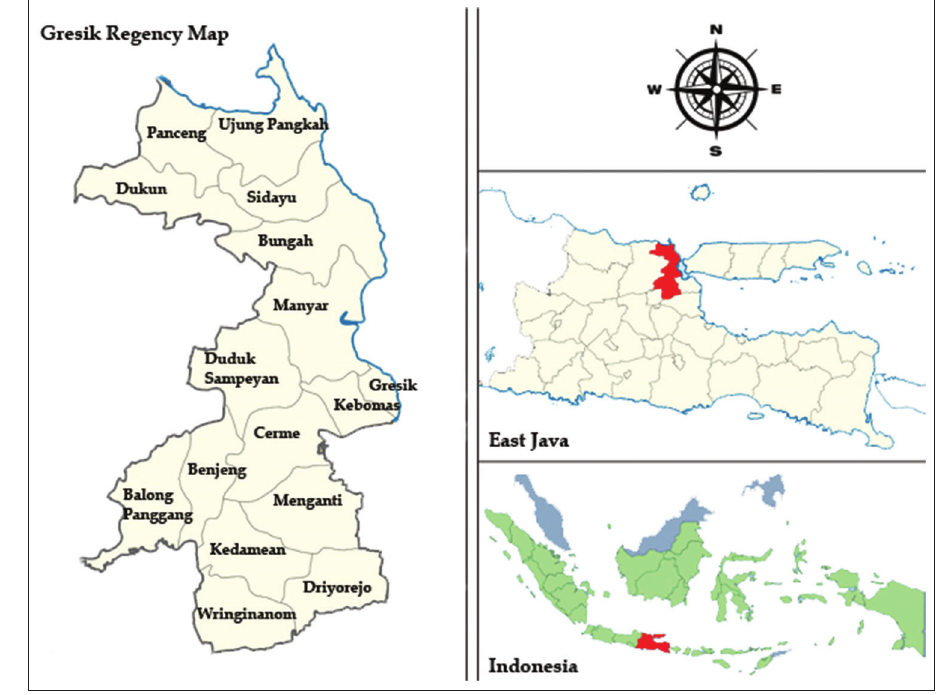
Figure-1: Gresik regency map [Source: